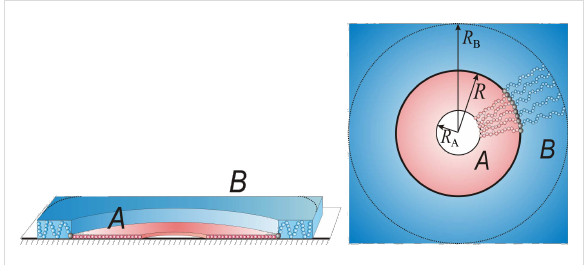
Figure 8: Schematic representation of an inverse torus-like structure.